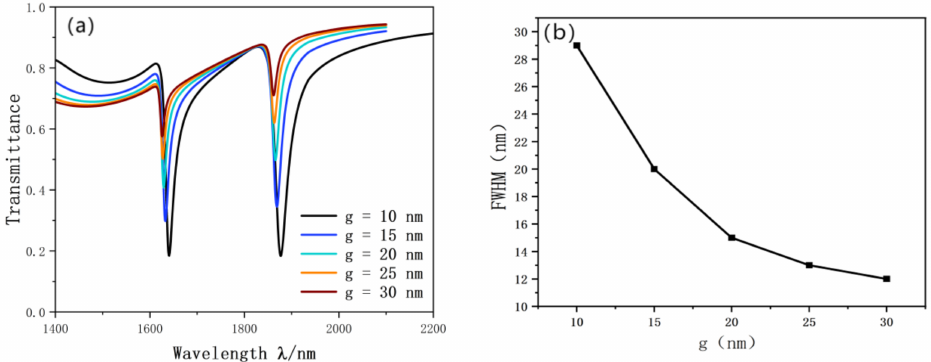
Figure 10. ( a ) Transmission spectrum of g variation; ( b ) trends in FWHM. It is obvious that the sensitivity of the sensor decreases sharply with the increase of g. The coupling results also appear unsatisfactory with the increase of g. After